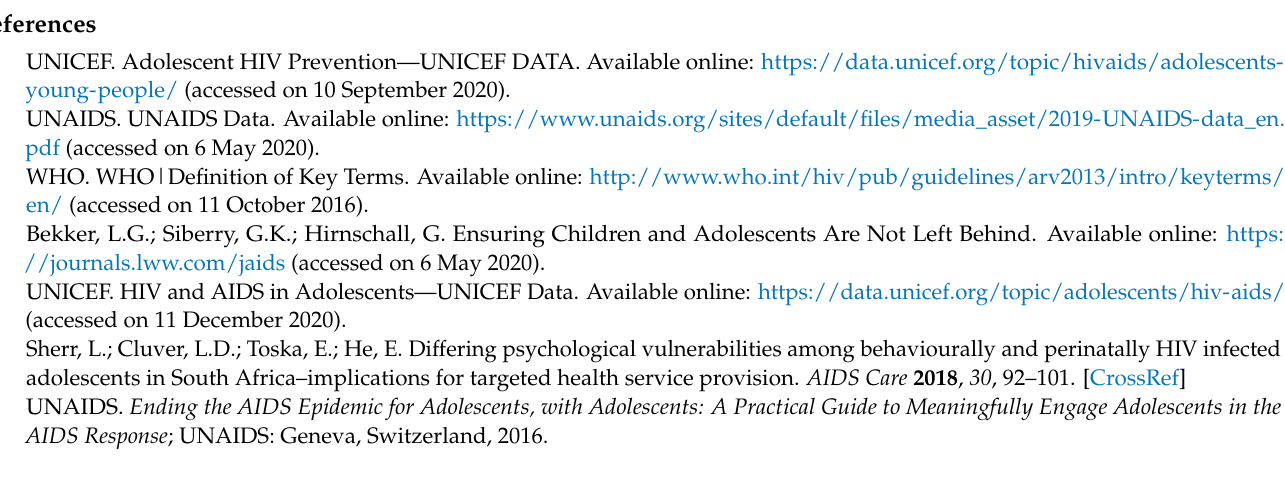
Table S2: Data Extraction